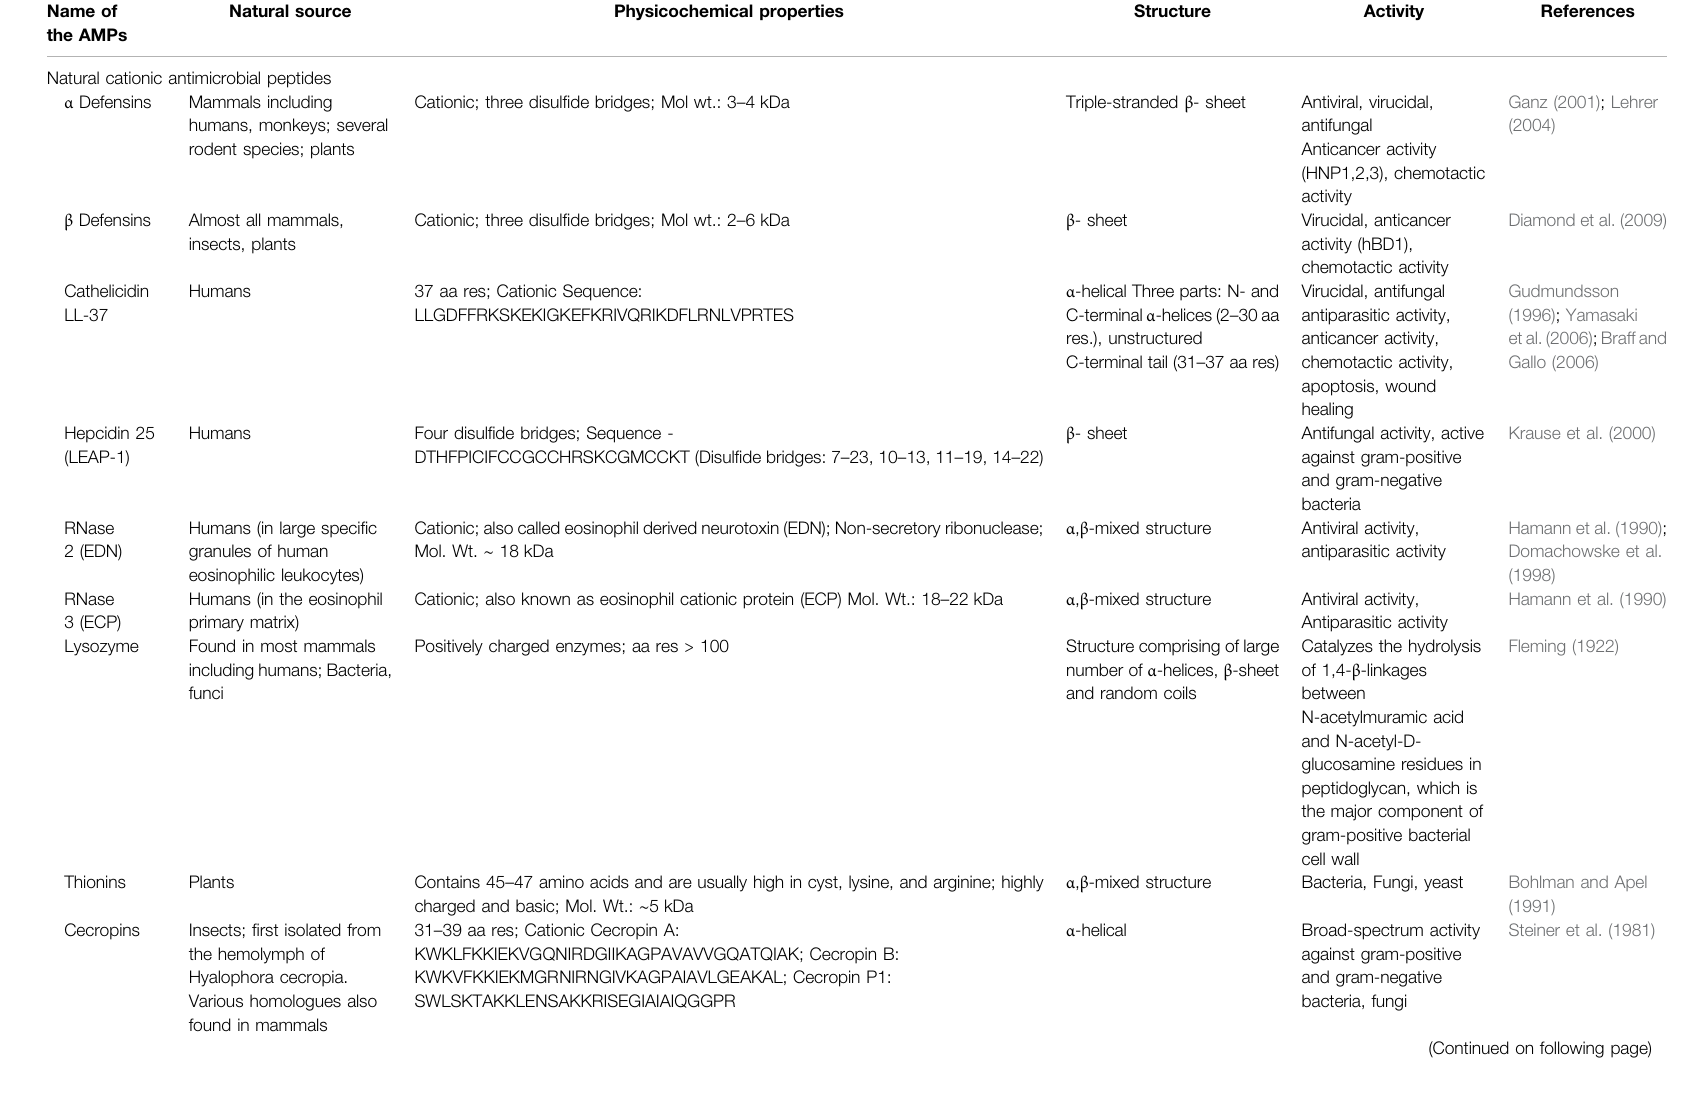
TABLE 1 | Natural antimicrobial peptides (aa (cid:1) amino acid; res (cid:1) residues). Name of the